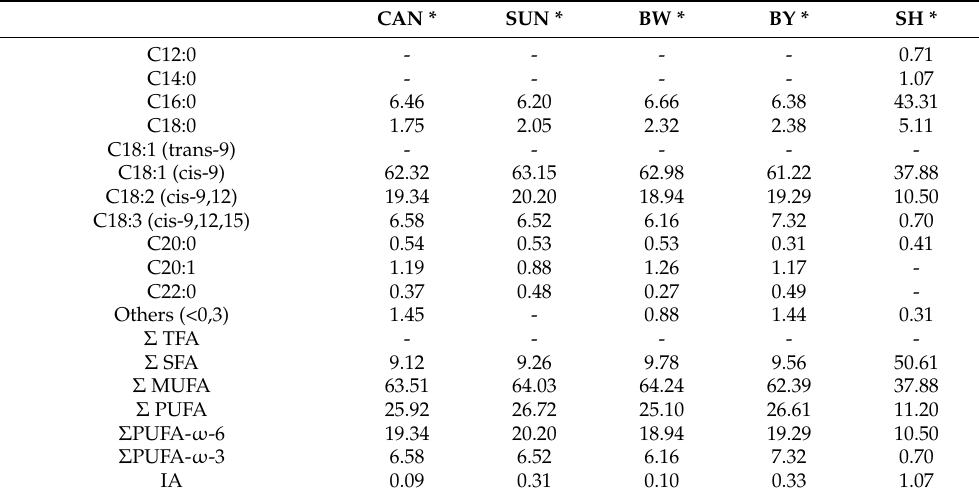
Table 7. Fatty acid composition [%] and the atherosclerotic index (IA).